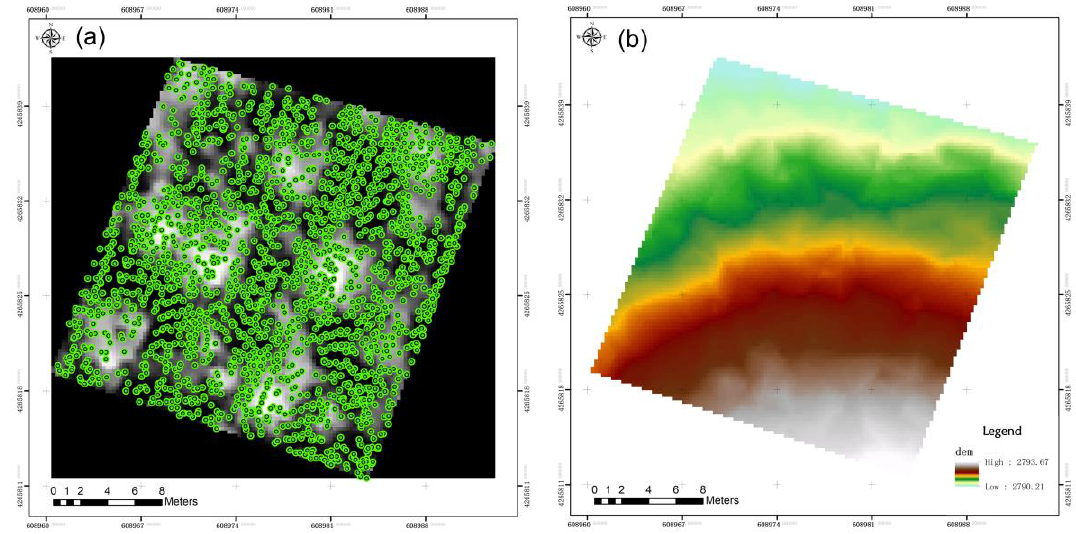
Figure 4. Predicted HCB (m) of trees against y-coordinate Y (m) located within coordinate X (608,960–608,970 m).